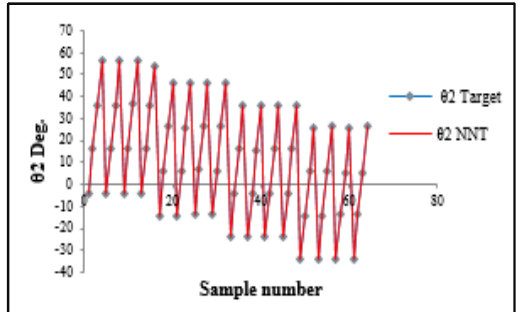
Fig. 16 the comparison between θ ONN.